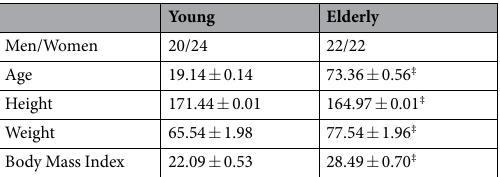
Table 4. Subjects characteristics by age group (elderly participants, n = 44; young participants, n = 44). Values are expressed as the mean ± SEM. ‡ p < 0.001, according to Welch t